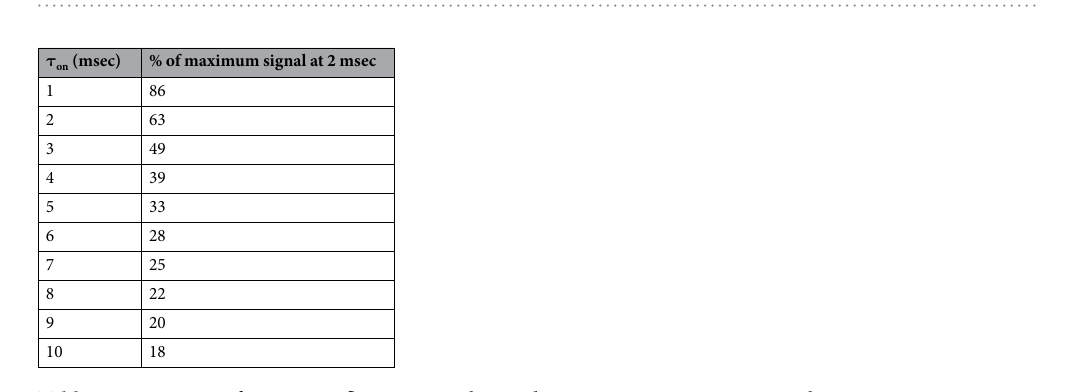
Table 3. Percentage of maximum fluorescence change during a 2 msec action potential. Approximating an action potential as a 100 mV depolarization that lasts for 2 msec enables the estimation of the optical signal as